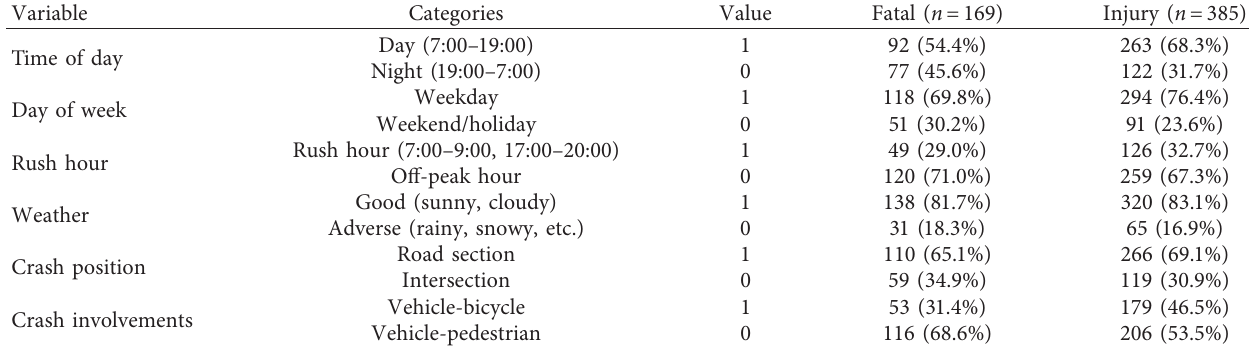
Table 1: Data list of main variables related to